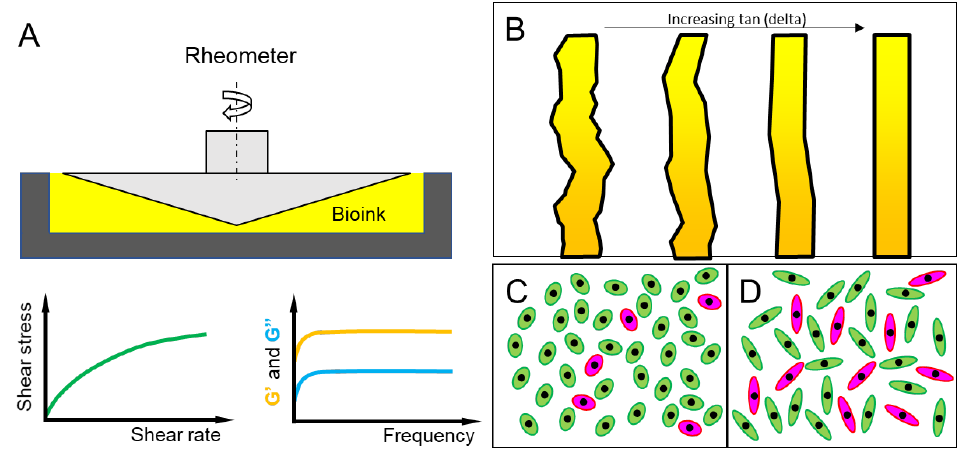
Figure 2. Rheological properties and their effects on bioprinting fidelity and cell viability. ( A ): Cone-and-plate rheometer and its application for evaluating the flow behavior and viscoelasticity of a bioink. ( B ): Influence of loss tangent on printed strand fidelity. ( C–D ): Influence of bioink viscosity on cell viability after bioprinting. A higher cell viability is found within lower viscosity ( C ) versus higher viscosity ( D ) bioinks. Green represents live cells and red represents dead cells.